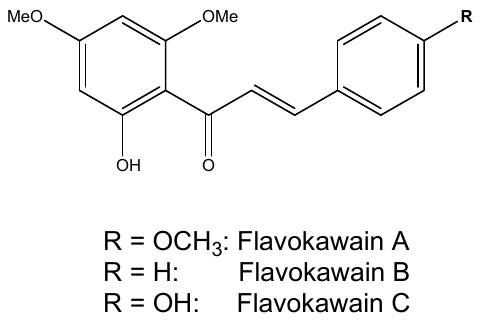
Figure 6. Chemical structures of flavokawains (FK) A, B, and C.